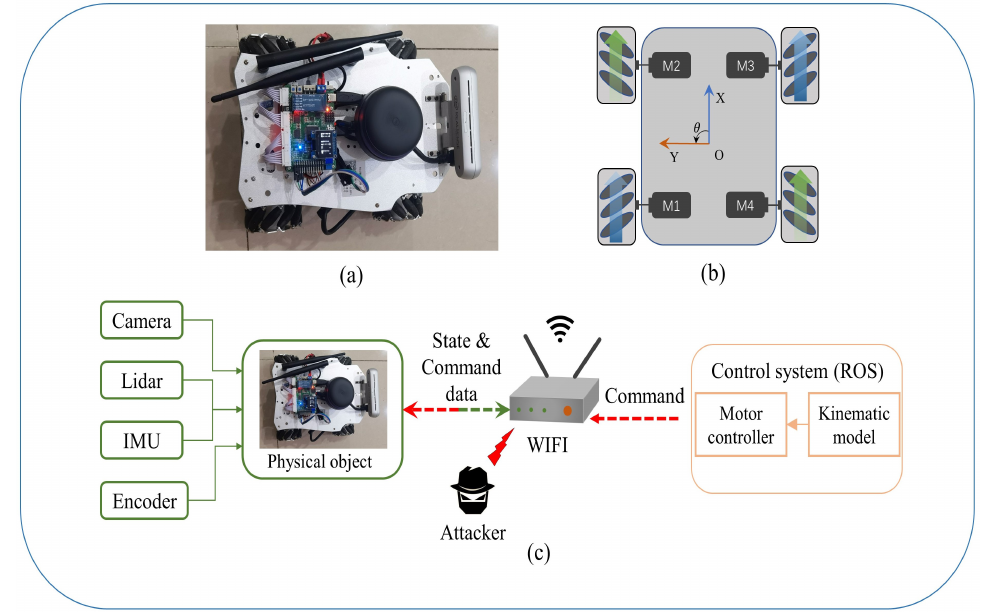
Figure 3. The structure diagram of data transmission in OMR’s CPS. ( a ) The physical picture of OMR; ( b ) the schematic diagram of robot coordinate system and wheel train arrangement; ( c ) CPS data transmission chain composed of OMR, WIFI router and control